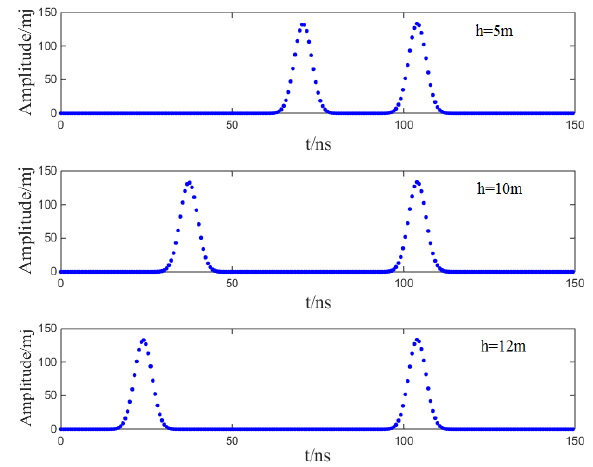
Figure 9. Echo waveform of different height building